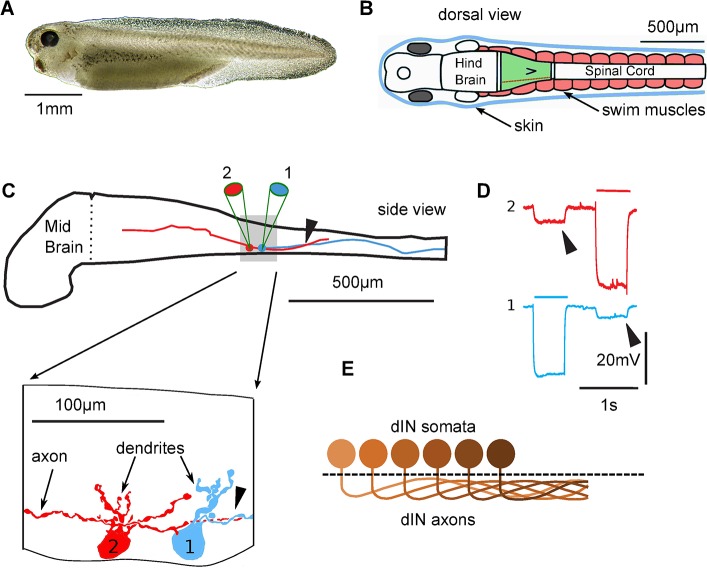
The hatchling tadpole CNS and a population of electrically coupled neurons (dINs).(A) Side view of a hatchling Xenopus laevis tadpole 48 hours after fertilisation. (B) Top view diagram of the tadpole showing skin, swimming muscles, and CNS with hindbrain and spinal cord. The CNS region able to generate swimming rhythm when isolated (green) contains a population of ~30 dIN neurons (brown) on each side. (C) Side view of the hindbrain and spinal cord showing diagrammatic recording electrodes (1 and 2) and tracings of two filled dINs (from [29]) with somata and short dendrites. dIN-1 has only a descending axon (arrowhead). dIN-2 also has an ascending axon (arrow). The intertwining of the axons can be seen (arrowheads). (D) Electrical coupling was shown using simultaneous voltage recordings from two dINs. Hyperpolarising current injection into either dIN (bars) caused a small voltage deflection in the other (arrowheads; from [29]). (E) Diagram of part of the dIN column with descending axons leaving the somata and intermingling where axo-axonic gap junctions could lie.